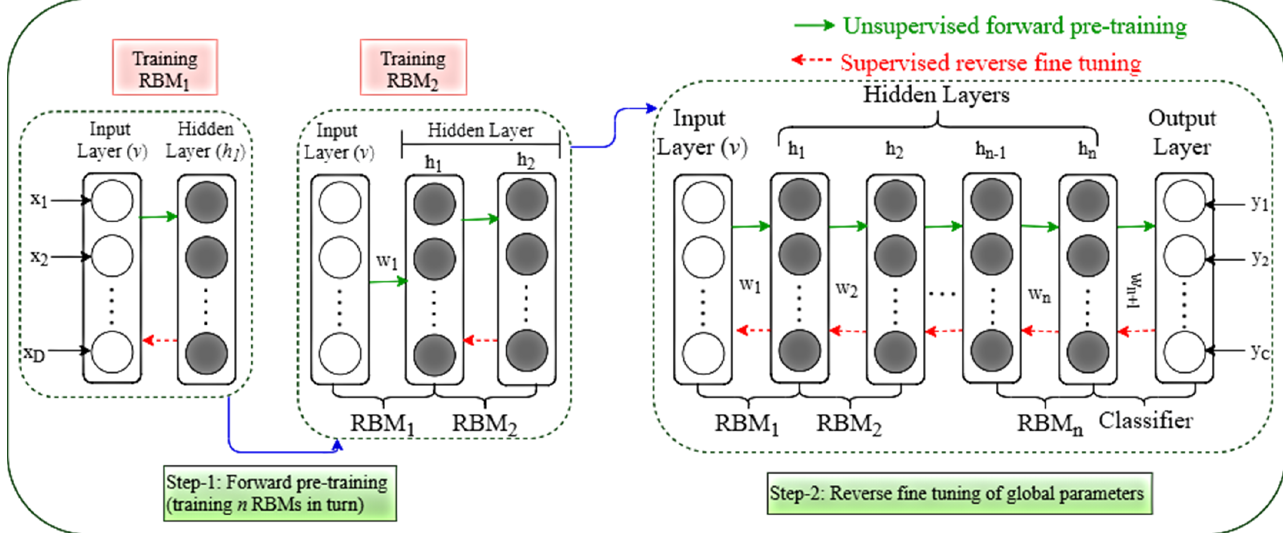
Figure 3. Training process of DBN.